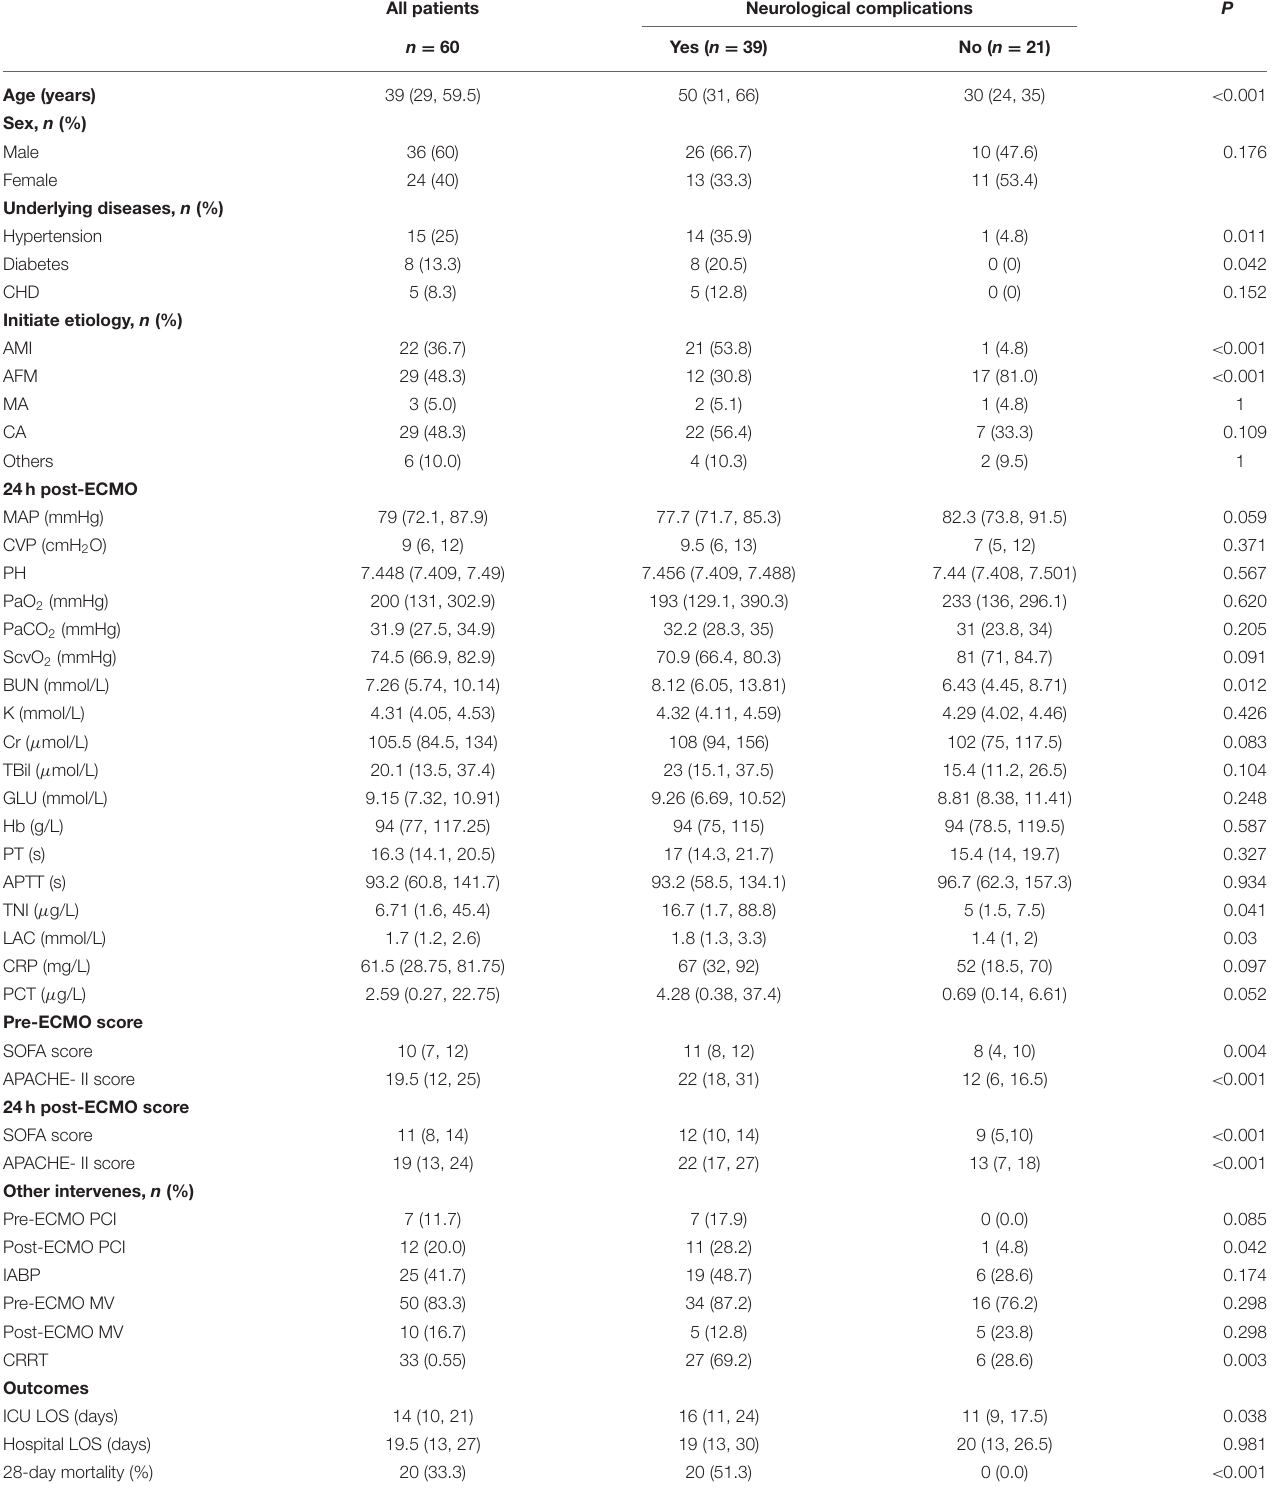
TABLE 1 | Comparison of baseline characteristics of patients. All patients Neurological